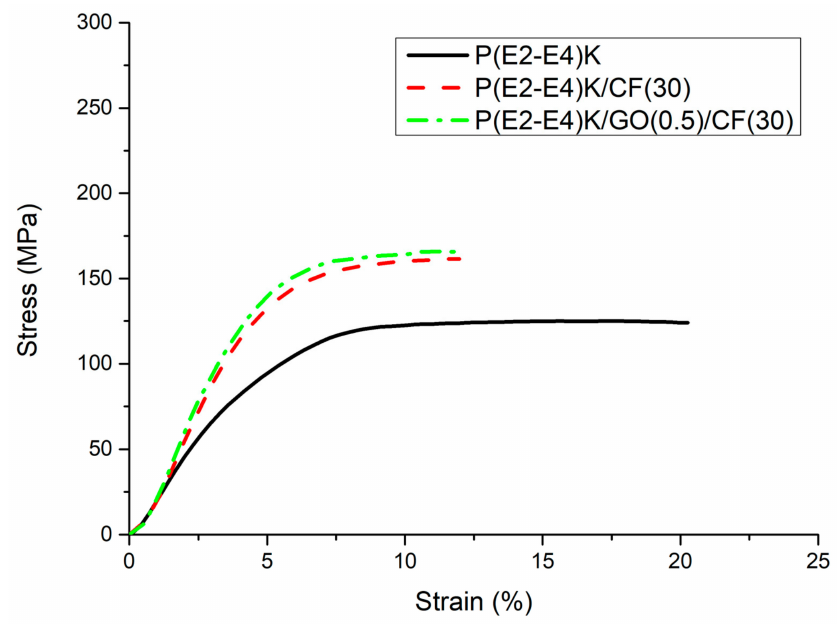
Figure 7. Compression stress-strain curves of the P(E2–E4)K composite